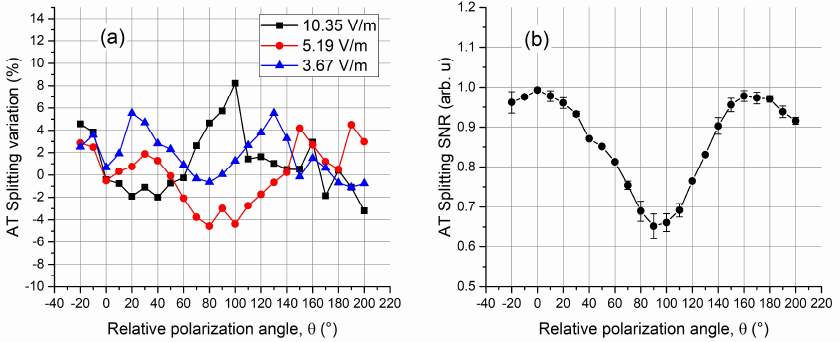
Figure 9. Influence of relative angles between laser polarization and RF E-field vector on the E-field strength measurement: ( a ) the variation in AT splitting determination relative to the splitting when laser polarization and RF E-field vector are well matched, and ( b ) normalized signal-to-noise ratio of the AT splitting.